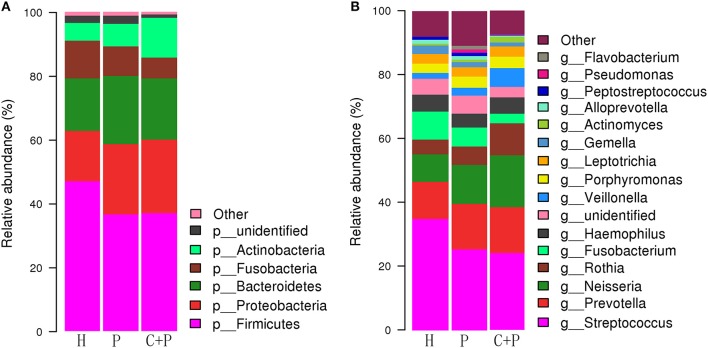
Relative abundance of major species in healthy controls (H), patients with periodontitis (P), and patients with both periodontitis and COPD (C+P). (A,B) shows the relative abundance of the bacterial species at the genus and phylum levels, respectively. Each column of the bar graph represents a group, and each patch represents a class of microorganisms in this group in proportion. <1% of the species were classified as other. OTUs were annotated by default QIIME UCLUST method with default settings and the GreenGene database.